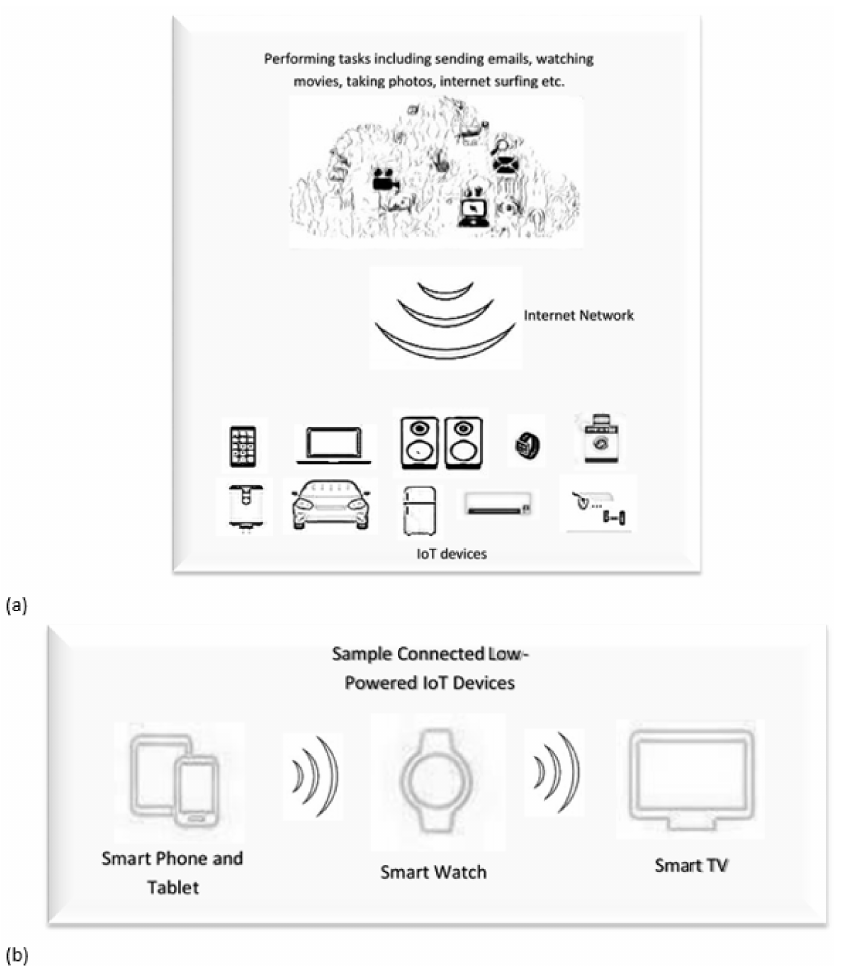
Figure 1. ( a ) Sample IoT devices connected to the internet to perform tasks; ( b ) sample connected IoT devices through